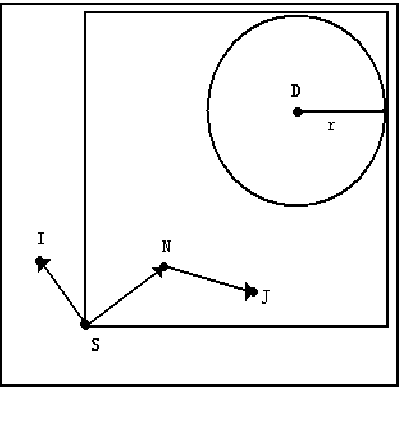
Figure 12. Static angle area [39]. Figure 13. Dynamic angle area